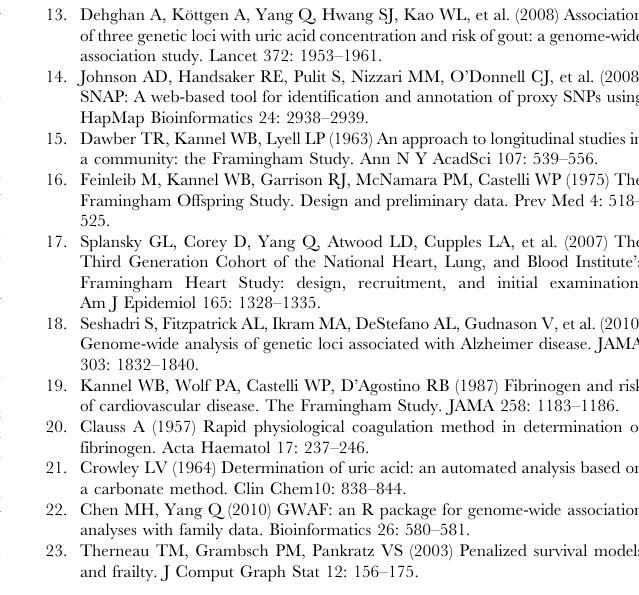
Figure S2 –log 10 (p-value) plot of rs4681 at various certainty thresholds for Fibrinogen. Figure S3 –log 10 (p-value) plot of rs3764261, rs1919484, rs10186236, rs1800588 at various certainty thresholds for HDL. Figure S4 –log 10 (p-value) plot of rs16890979, rs2231142, rs1165205 at various certainty thresholds for uric acid.